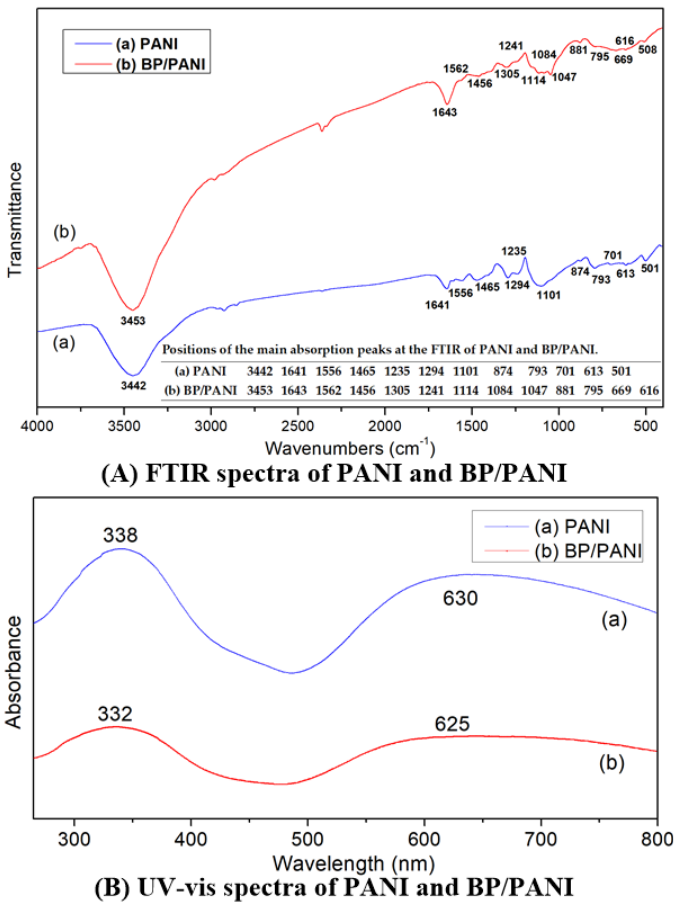
Figure 2. ( A ) FT − IR and ( B ) UV − vis spectra of (a) PANI and (b) BP/PANI.